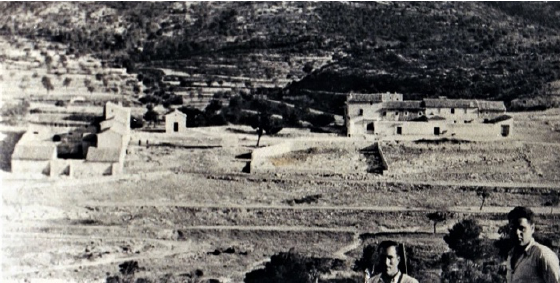
Figure 3. Mas de les Fermoses , a complex country house